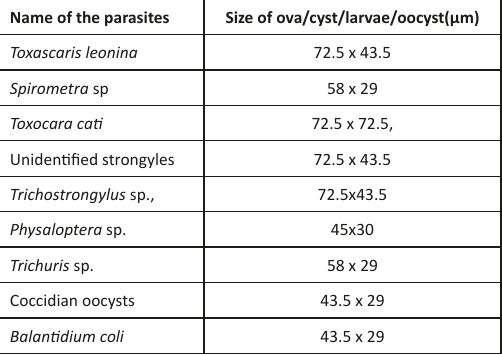
Table 4. The size of ova/cysts/oocysts of different